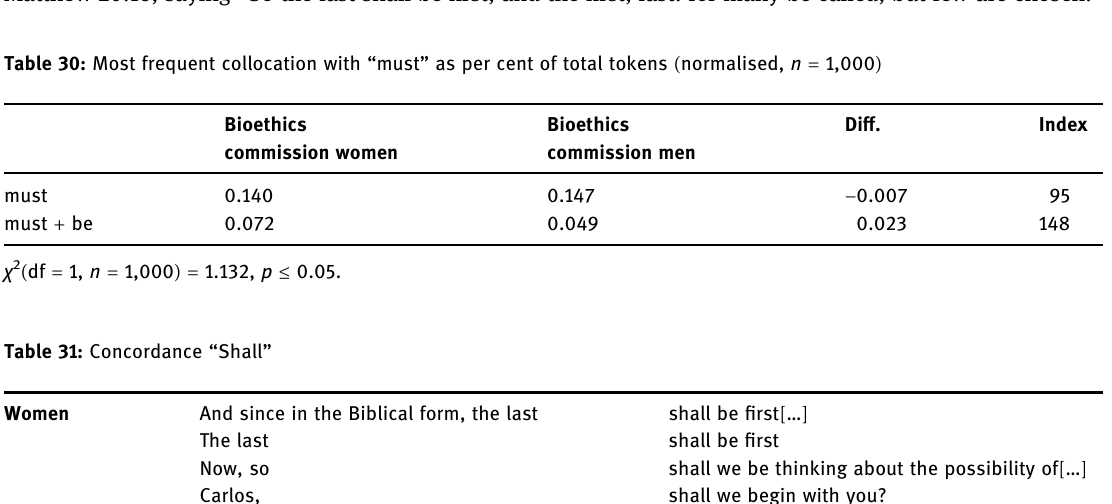
Bioethics commission women